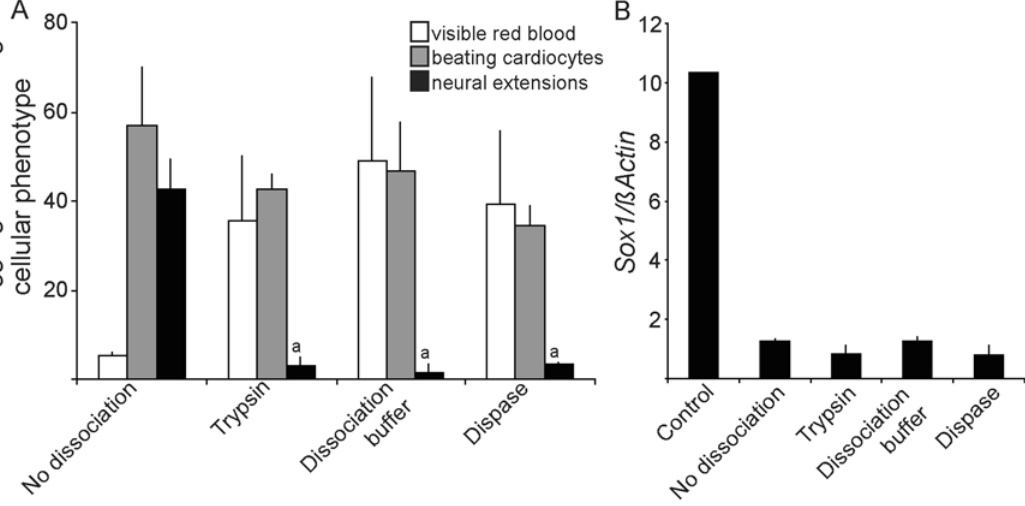
Figure 3. Dissociation, and not specific actions of Trypsin-EDTA, acts to suppress neurectoderm formation. ( A ). EPL cells, formed in aggregates in MEDII, were dissociated with Dispase, Dissociation buffer or Trypsin-EDTA, reaggregated and maintained for a further 4 days before being seeded individually into 48 tissue culture wells and allowed to differentiate. Aggregates were scored for the presence of beating cardiocytes and neural extensions and the peak score for each represented. Outcomes are compared to outcomes from EPL cells that were maintained in aggregates. n=3 independent experiments. Error bars represent sem. (a) denotes a decrease compared to MEDII 2 /Dissociation 2 where p , 0.01. ( B ). EPL cells, formed in aggregates in MEDII, were either maintained in medium supplemented with 50% MEDII (control), cultured in unsupplemented medium (no addition) or dissociated with Dispase, Dissociation buffer or Trypsin-EDTA, reaggregated and maintained in suspension culture in unsupplemented medium for a further 6 days. Aggregates were collected and extracted RNA was analyzed for the presence of Sox1 , and GAPDH by real-time PCR. n=3 independent experiments. Error bars represent sem.